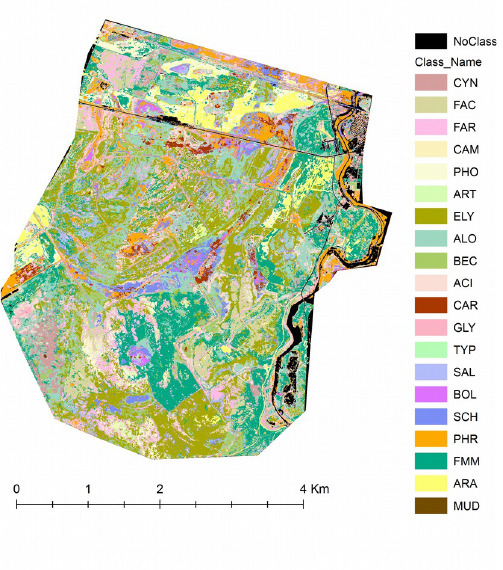
Figure 4. Vegetation map (A) of the study site produced using SVM classification with 30 random training pixels per class.